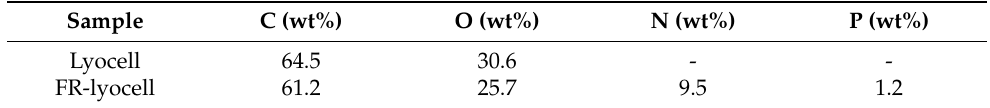
Table 2. Element composition of lyocell and FR − lyocell samples.